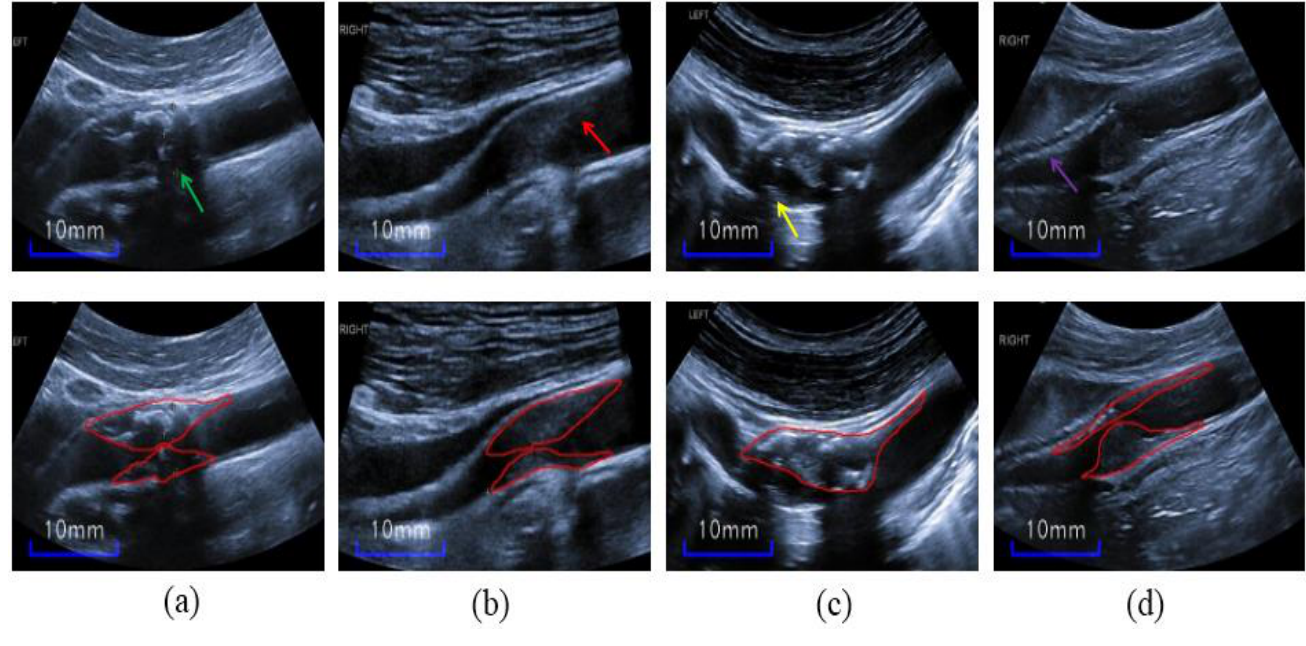
Figure 2. Carotid plaques in ultrasound images from four patients. Top row: ( a ) The green arrow indicates acoustic shadow, ( b ) the red arrow indicates speckle noise, ( c ) the yellow arrow indicates artifacts, and ( d ) the purple arrow indicates the ambiguous boundary between the plaques and IMC. Bottom row: The red outlines superimposed on the images denote the plaques contours.